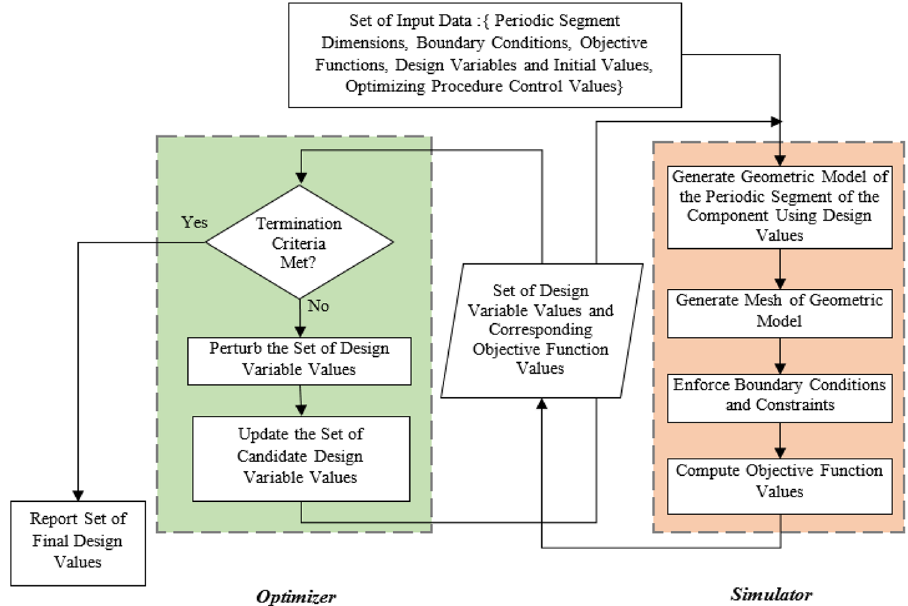
Fig. 5. Illustration of the framework developed for multi-objective optimization of mechanical component